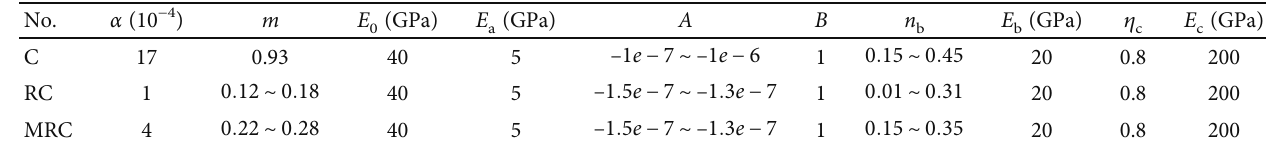
Table 2: Constitutive parameter